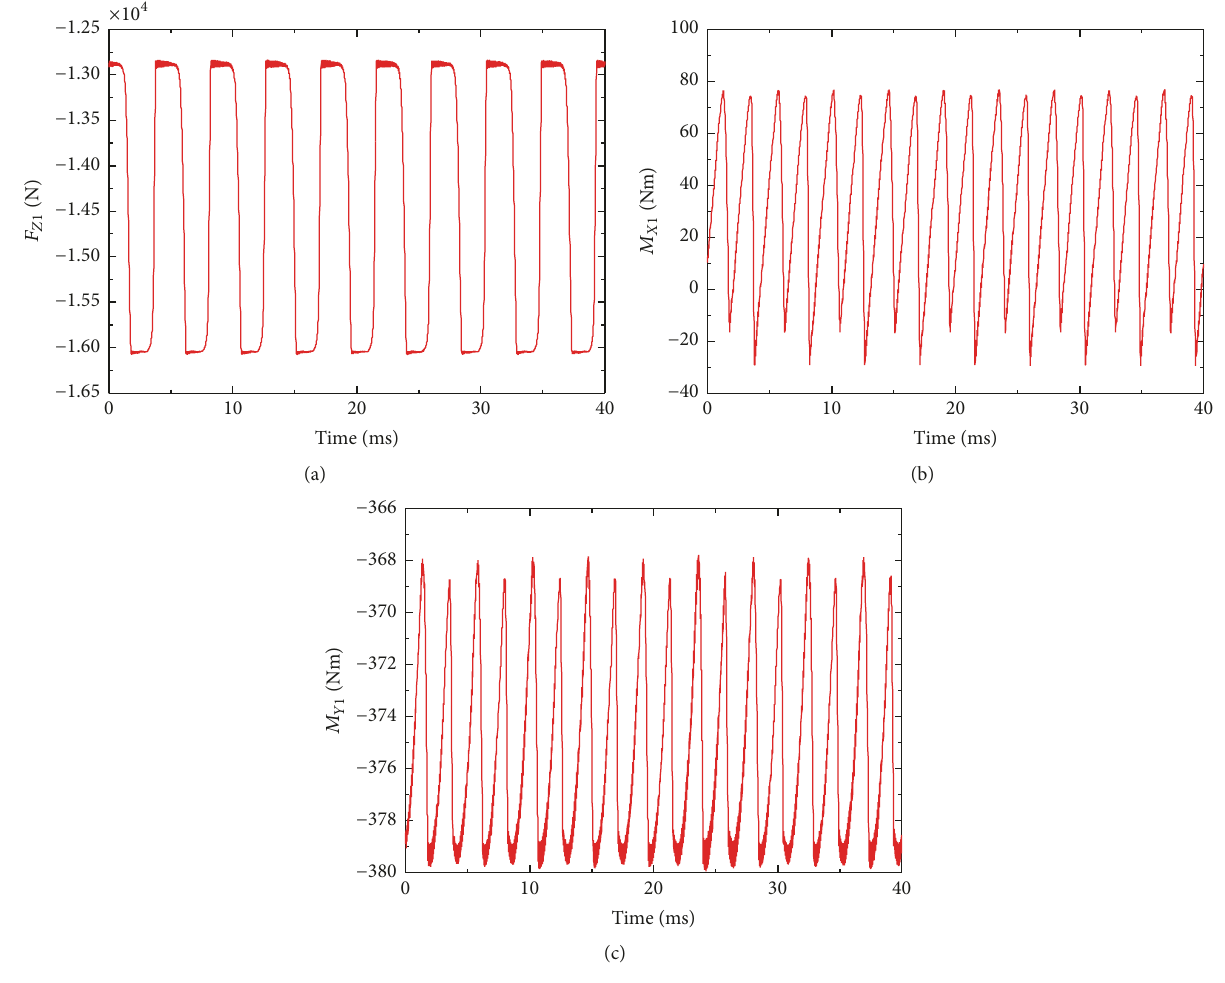
Figure 6: Variations of 𝐹 𝑍1 , 𝑀 𝑋1 , and 𝑀 𝑌1 in time domain.